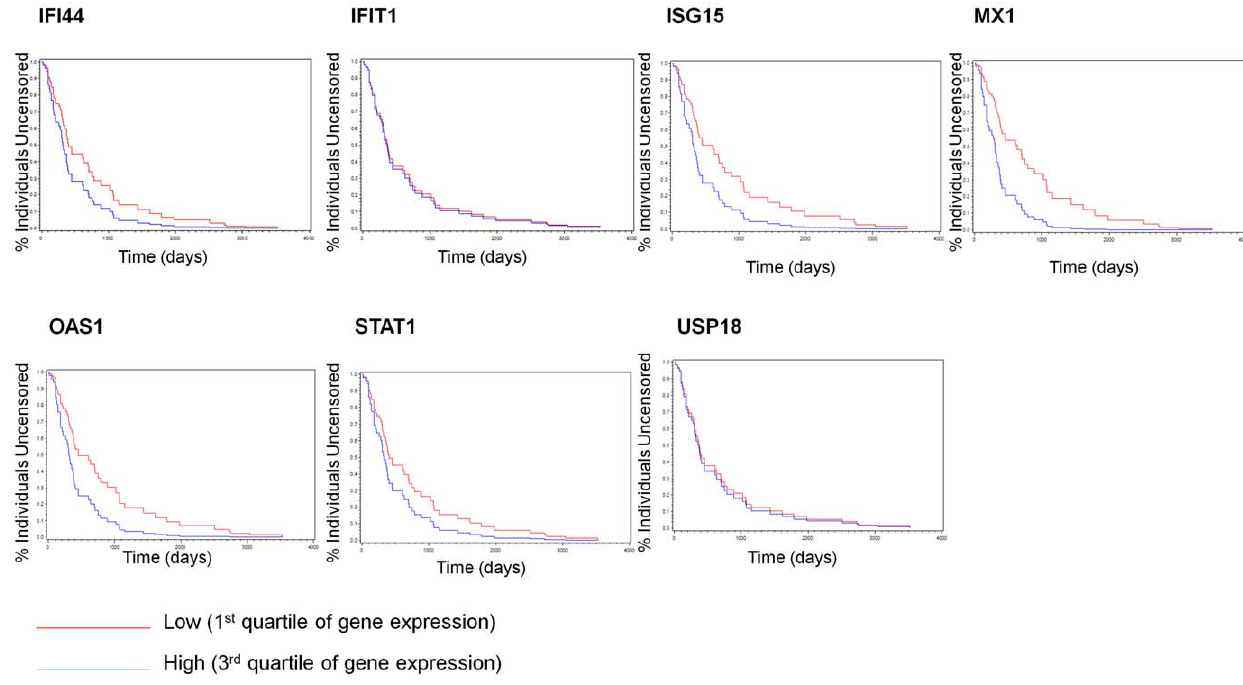
Figure 1. Survival Curves for age-adjusted Cox Proportional Hazard models for 1 st quartile (red) and 3 rd quartile (blue) gene expression values for each gene in the Proneural